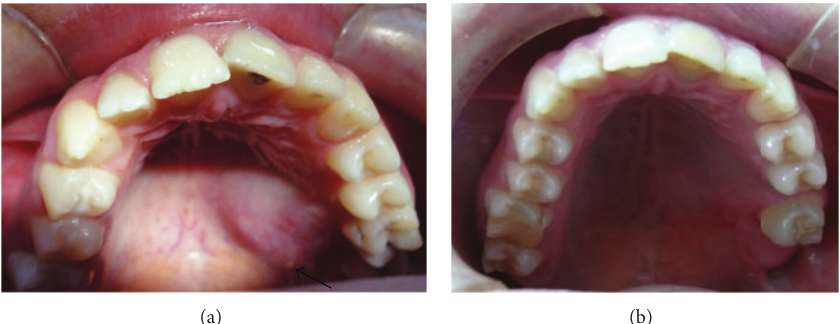
Figure 1: (a) Preoperative intraoral image of a mucoepidermoid carcinoma of the left posterior hard palate with 8mm diameter and fistula opening (black arrow). (b) Postoperative (3 years) image of a reconstructed palate.